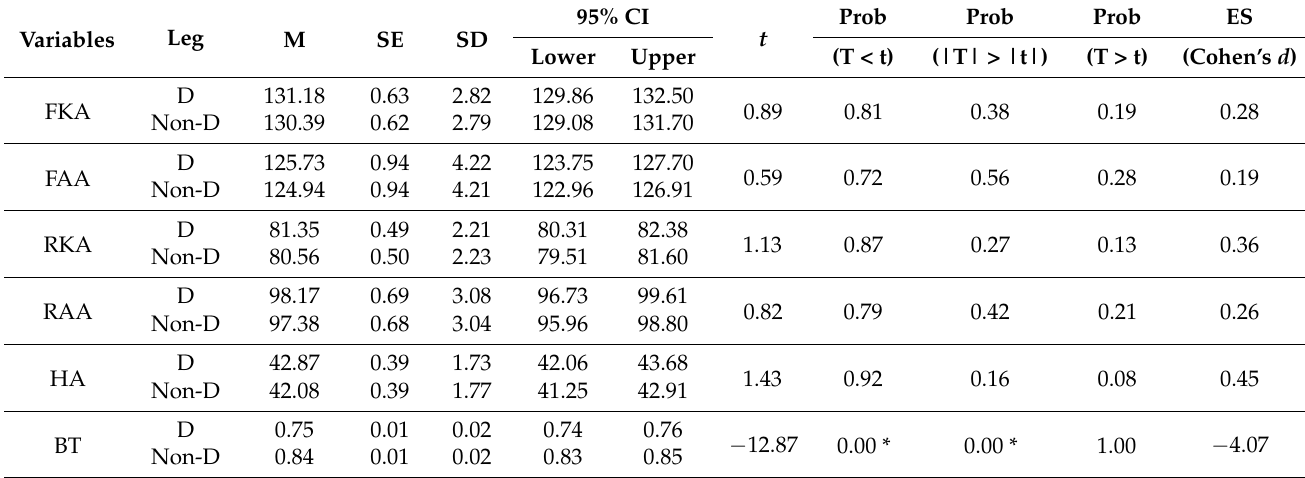
Table 2. Effects of leg dominance on kick-start parameters—block